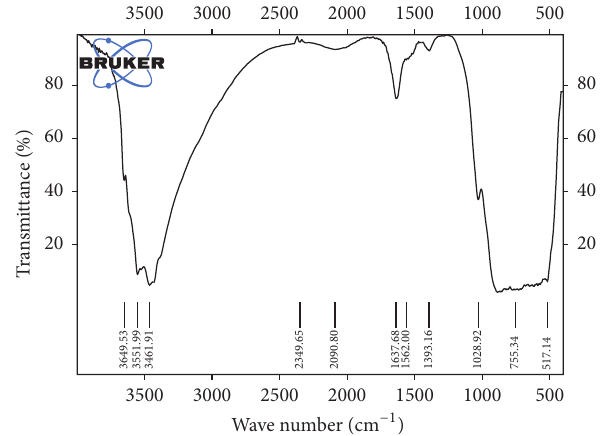
Figure 2: FTIR spectrum of 𝛾 -alumina